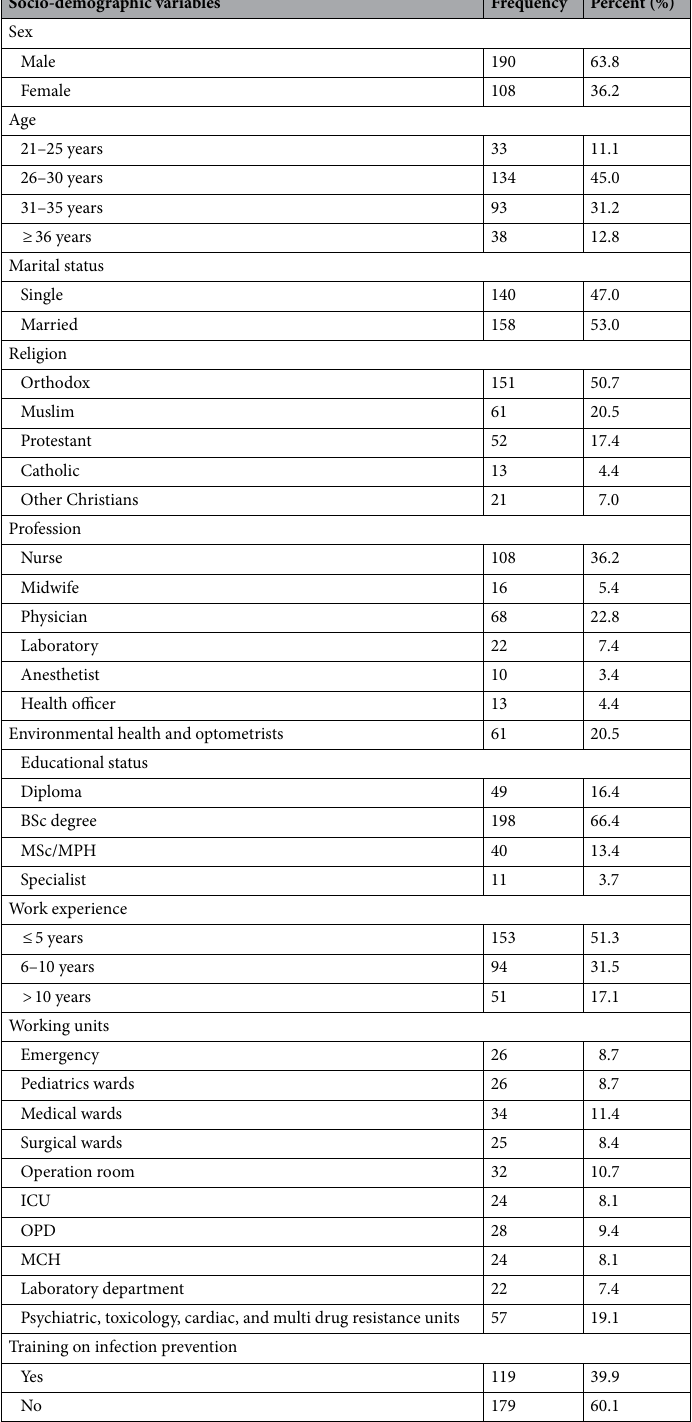
Table 1. Sociodemographic characteristic of healthcare workers (n = 298) in St. Peter’s specialized hospital in Addis Ababa, Ethiopia, April 2022. ICU Intensive care units, OPD Outpatient department, MCH Maternal and child